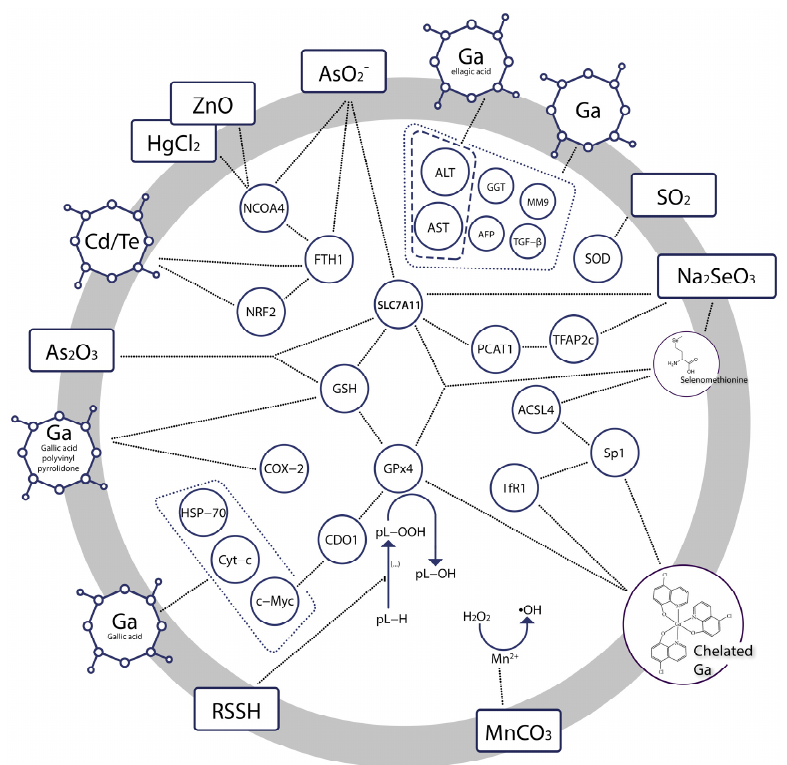
Figure 1. Molecular effectors associated with ferroptotic induction by bioinorganic compounds. Abbreviations: alanine transferase (ALT), aspartate transferase (AST), gamma-glutamyltransferase